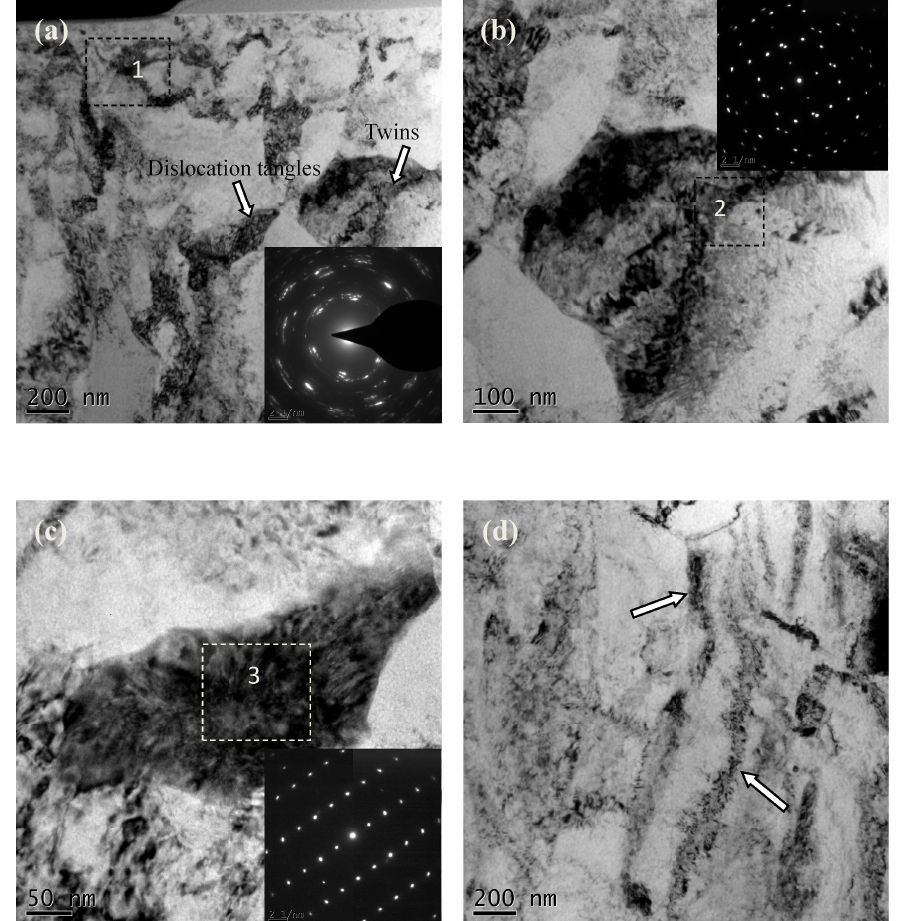
Figure 5. TEM images of sample treated by MUSR using 30 kHz and 900 N at the depth range of 2–6 μ m from the treated surface: ( a ) the depth of 3 μ m; ( b ) deformation twins; ( c ) dislocations tangles; 2–6 µ m from the treated surface: ( a ) the depth of 3 µ m; ( b ) deformation twins; ( c ) dislocations tangles; ( d ) the depth of 6 μ m. ( d ) the depth of 6 µ